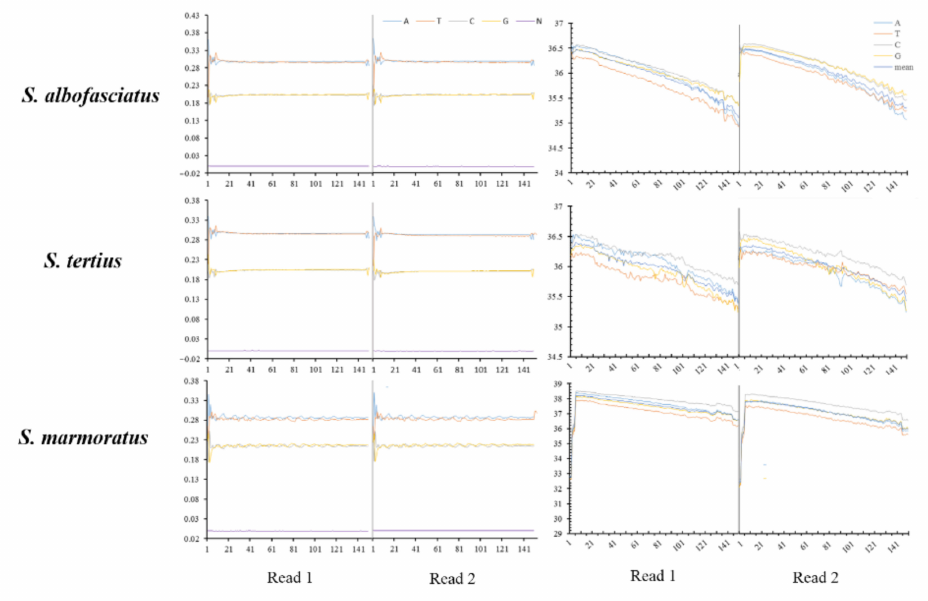
Figure 1. Distribution figure of sequencing quality and GC content of clean